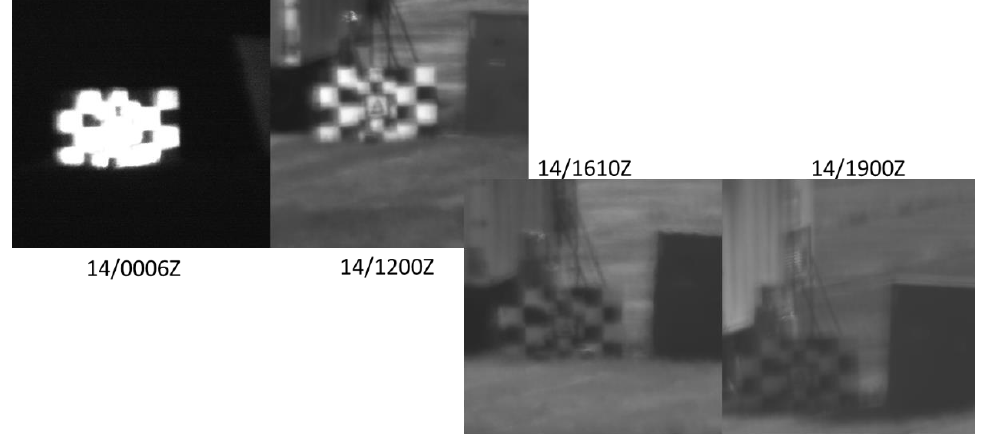
Figure 10. Representative, individual image frames recorded at multiple times on 14 July using the DELTA eight-inch aperture camera at 100 Hz frame rate. As noted earlier, the system measures the differential motion, or tilts between pairs of feature points on the target as a function of their angular separation.